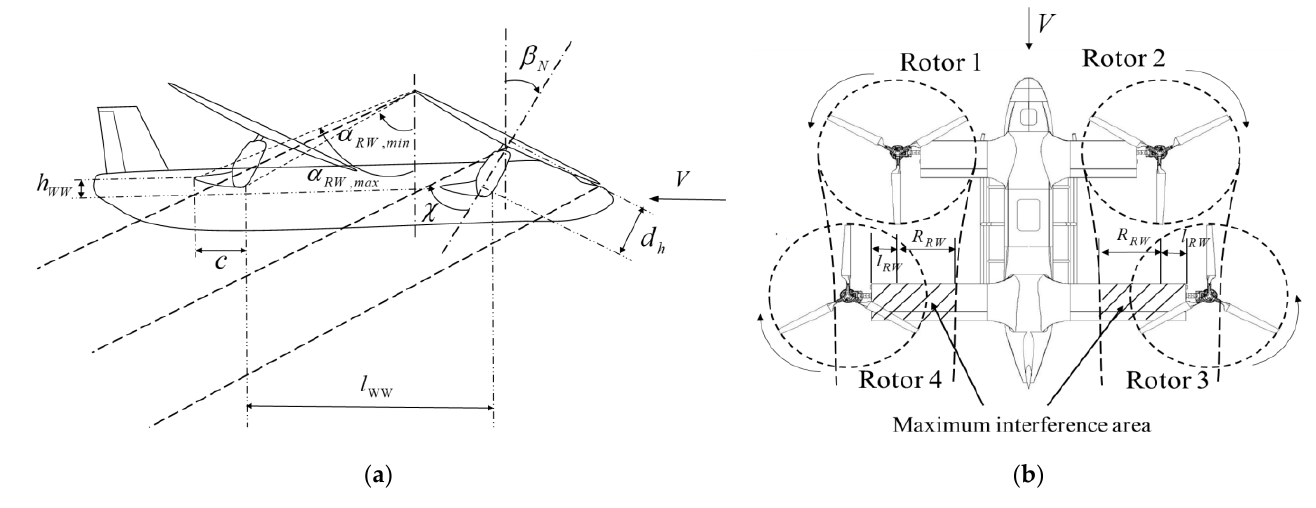
Figure 5. Interactional diagram of front rotor wake to the rear wing. ( a ) Side view of interference. ( b ) Top view of interference.